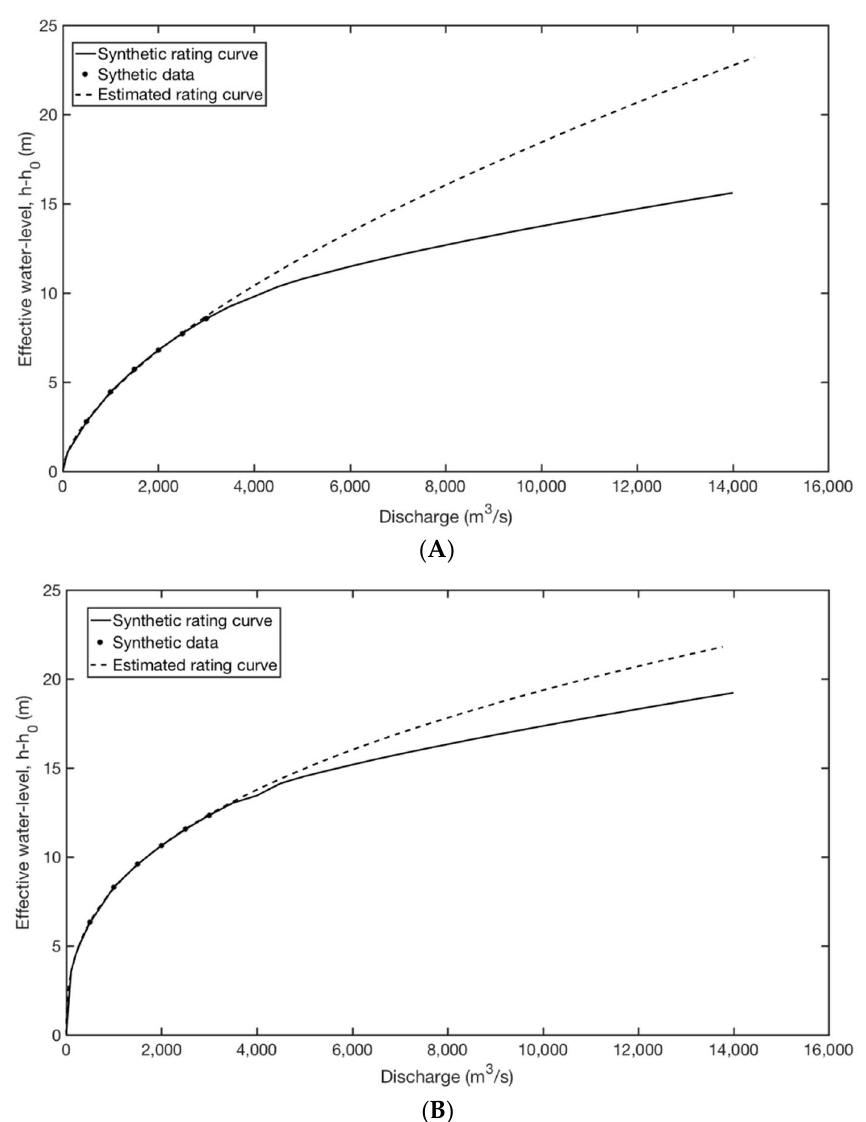
Figure 2. Synthetic and estimated rating curves derived using the Hydrologic Engineering Center’s River Analysis System (HEC-RAS) model and the power law models for two cross-sections located 58 km ( A ) and 68 km ( B ) downstream of Cremona (Po River, Italy). 58 km ( A ) and 68 km ( B ) downstream of Cremona (Po River,